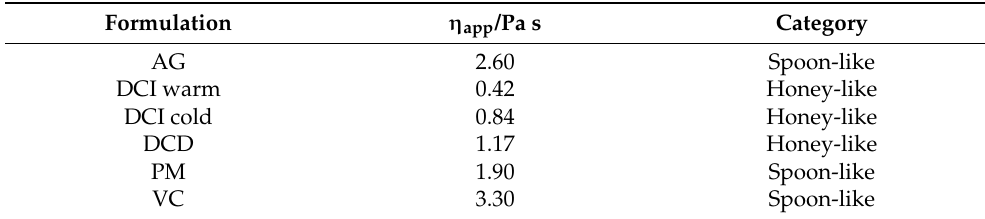
Table 5. Apparent viscosity values measured at and new